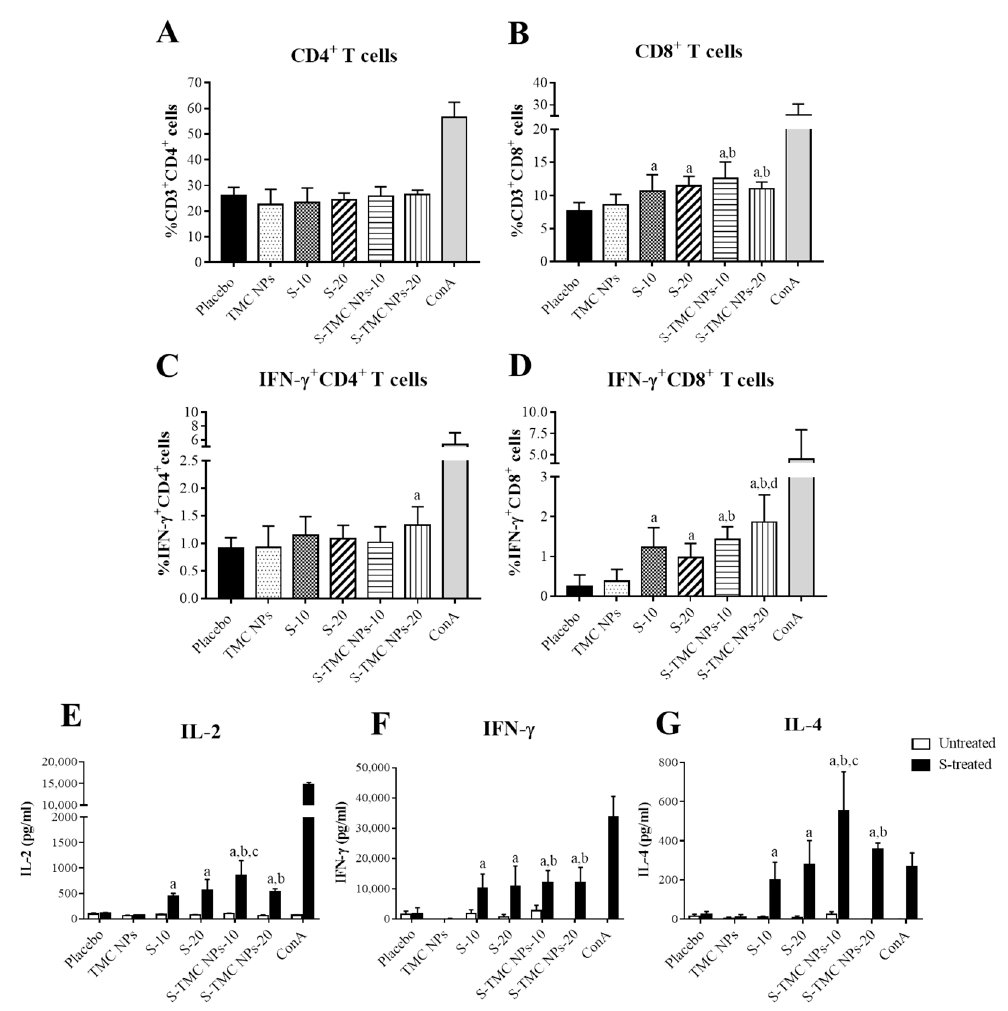
Figure 4. Cellular immune responses to soluble S-protein or S-TMC NPs. Splenocytes of immunized mice that received three doses of soluble S-protein or S-TMC NPs were isolated and stimulated ex vivo with 10 μ g/mL of S-antigens for 72 h. Frequencies of S-specific CD4 + ( A ), CD8 + ( B ), IFN- γ + CD4 + ( C ) and IFN- γ + CD8 + ( D ) T cells in cultures of stimulated splenocytes were monitored by antibody staining, followed by analysis using flow cytometry. The levels of splenic cytokines, including IL-2 at 24 h ( E ), IFN- γ at 72 h ( F ) and IL-4 at 72 h ( G ) after antigen stimulation, were quantitated by ELISA. The results are presented as means ± SD ( n = 4); “a” indicates significant differences between placebo and soluble S-protein or S-TMC NPs. “b” indicates significant differences between TMC NPs and S-TMC NPs. “c and d” indicate significant differences between soluble S-protein and S-TMC NPs at 10 and 20 μ g/dose, respectively ( p < 0.05).